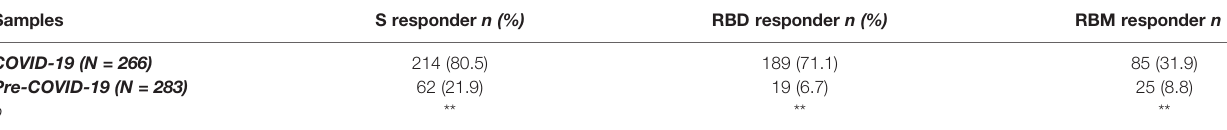
TheproportionofrespondersamplesagainstS,RBD,andRBMwascalculatedusingthesamplesshowinganantibodymeanOD ≥ meanOD+3SDofthenegativecontrolsatthedilution 1:100 (indicated as the ELISA cutoff). Fisher ’ s exact test was used to compare the proportion of responders between the COVID-19 and pre-COVID-19 groups. N, total number of samples; n, number of responder samples; %, percent of responder samples; RBD, receptor-binding domain; RBM, receptor-binding motif; OD, optical density. **p ≤ 0.01.